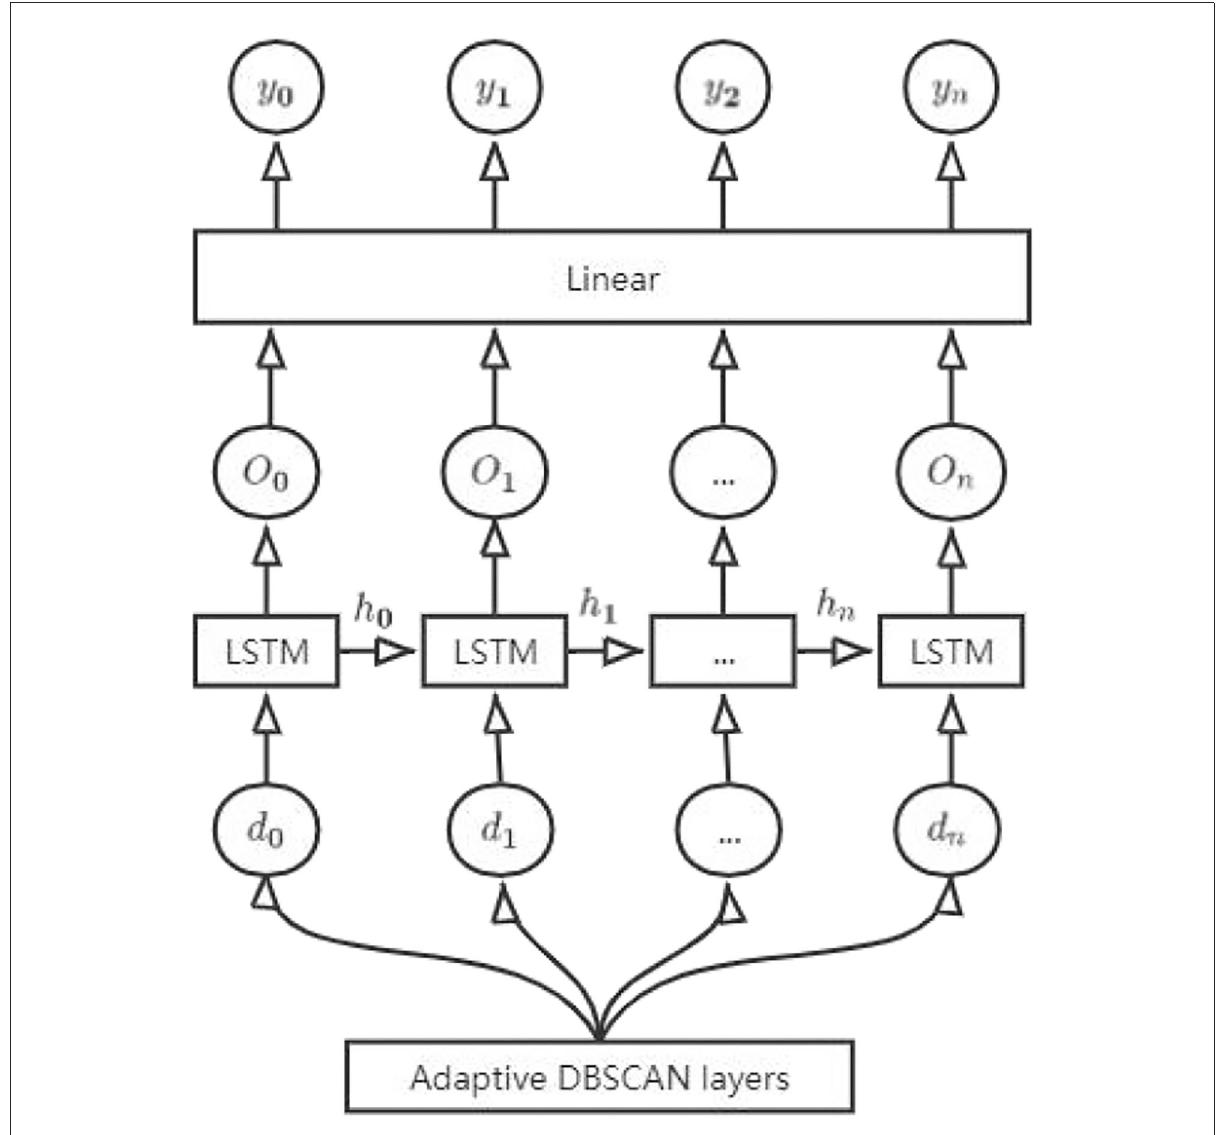
FIGURE2 Structure diagram of the improved